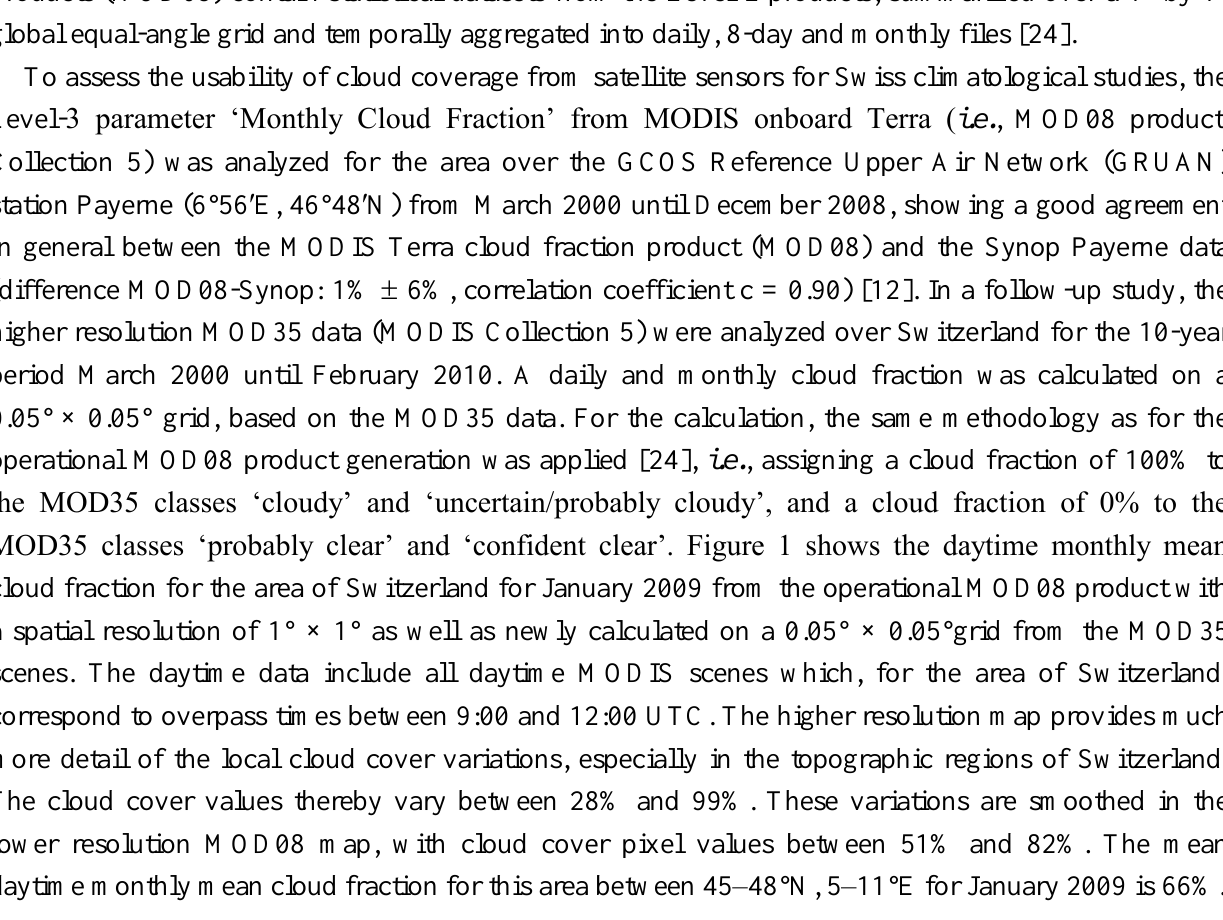
Figure 1. Monthly mean cloud fraction from MODIS Terra over Switzerland